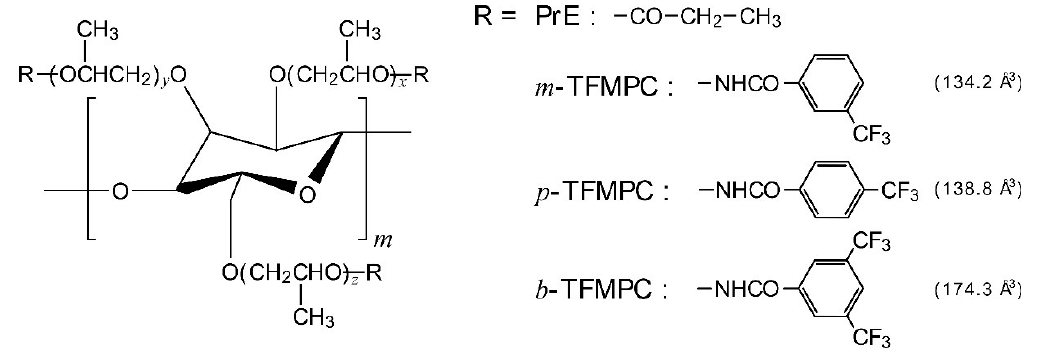
Figure 1. Chemical structures of hydroxypropyl cellulose (HPC) derivatives that possess both propionyl esters and three kinds of (trifluoromethyl)phenyl carbamates in the side chains. The numbers on the right side of the (trifluoromethyl)phenyl groups are their molecular occupied volumes estimated by the empirical molecular modeling simulation.